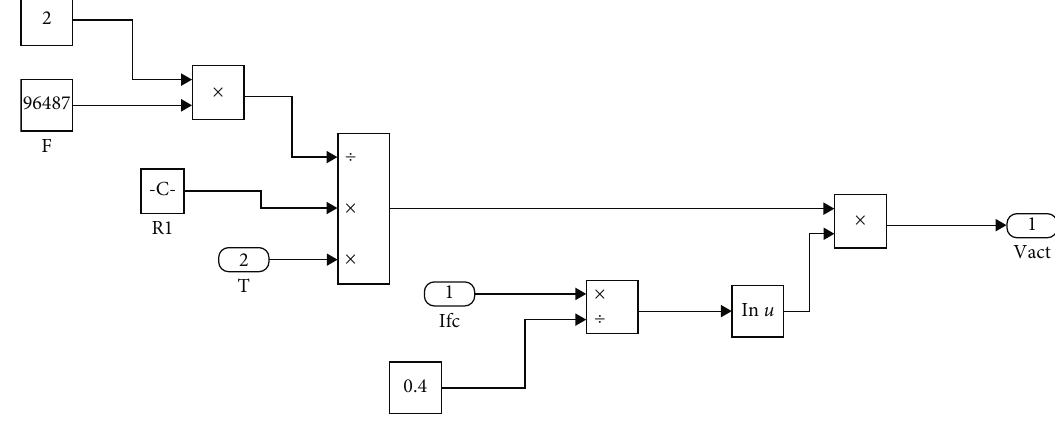
Figure 11: Simulink model for activation loss of SOFC.